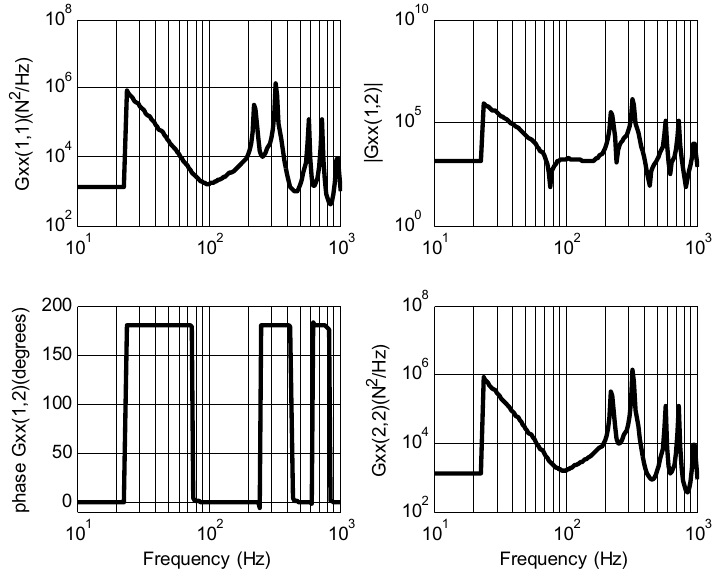
Fig. 6. Example 1, Input cross spectral density.